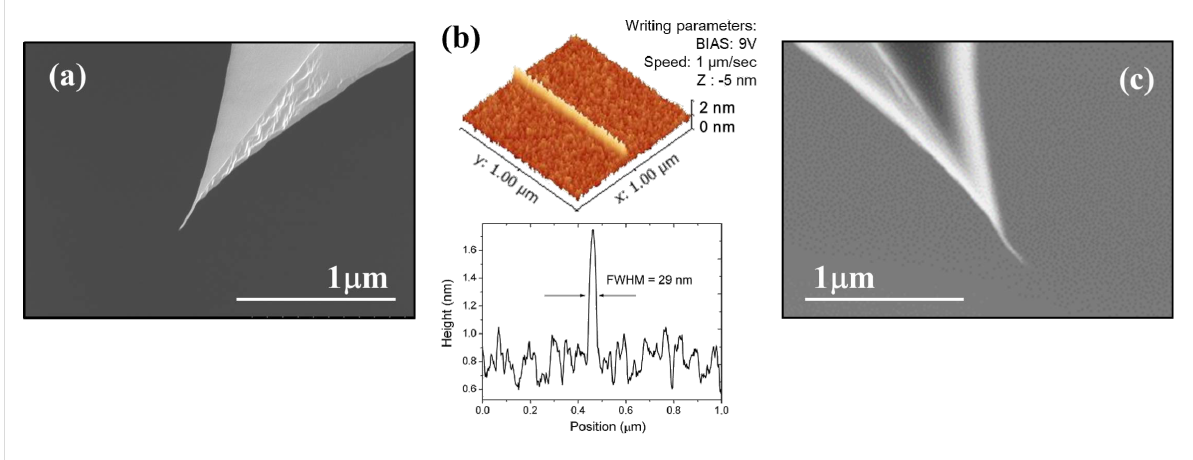
Figure 4: Monitoring chemical and mechanical stability of CNF probes for LAO-AFM. SEM images before (a) and after (c) the definition of 1 μ m long line feature, written at 9 V and a writing speed of 1 μ m/s (b). The FWHM of the line is about 29 nm.